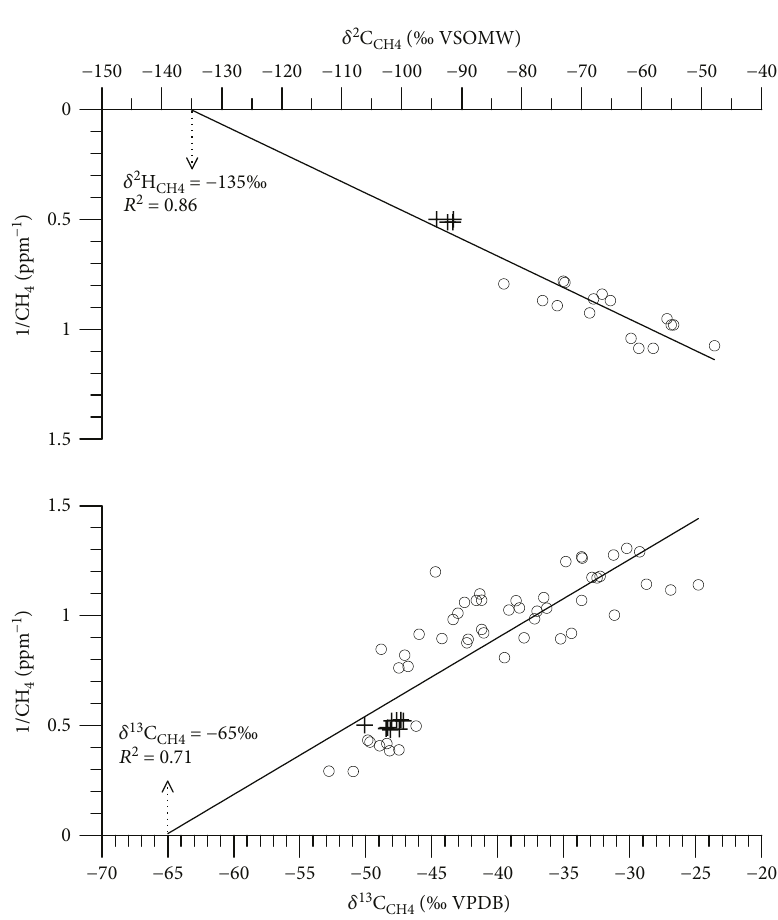
Figure 8: Keeling plots of δ 13 C and δ 2 H from cave air. The open circles represent cave air samples, and crosses represent the outdoor CH4 CH4 atmosphere.TheKeelingplotof δ 13 C wasmadewiththeentiresetofairsamplescollectedthroughouttheeight fi eldcampaigns,whereasthe CH4 δ 2 H -Keeling was plotted with the measurements obtained during the last two fi eld campaigns. The vertical dotted arrows indicate the CH4 isotopic compositions ( δ 13 C and δ 2 H ) for the source of CH that has been added to the cave air to produce the composition observed CH4 CH4 4 at each